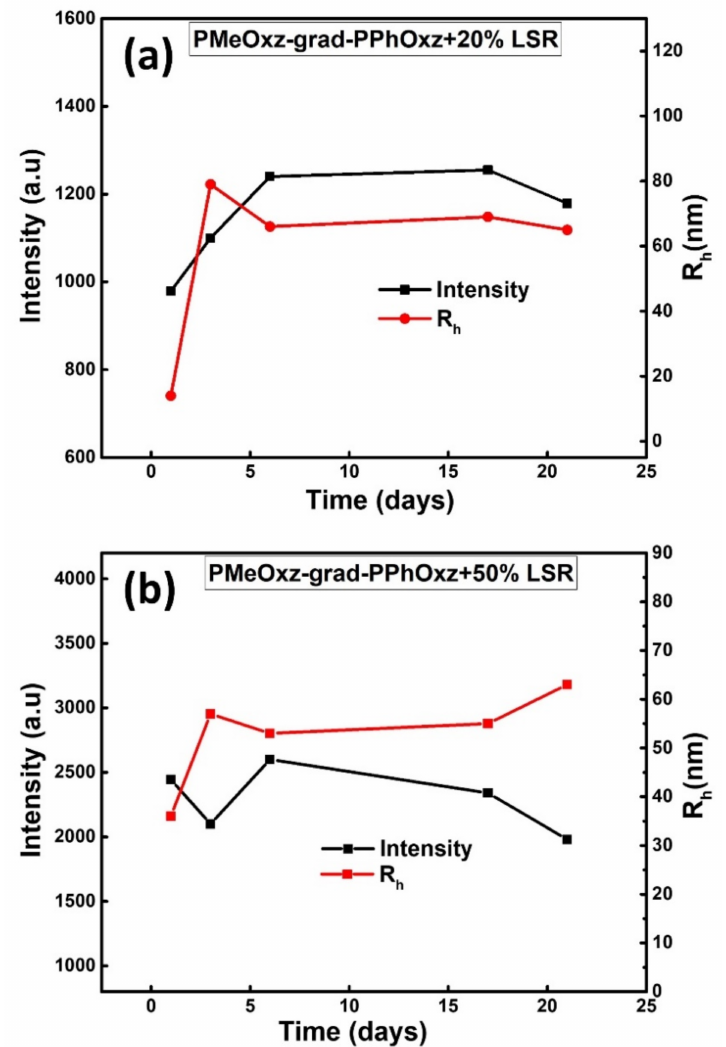
Figure 6. Scattered intensity and R h measurements (from cumulant analysis) versus time obtained from DLS of ( a ) PMeOxz 72 -grad-PPhOxz 28 + 20% LSR and ( b ) PMeOxz 72 -grad-PPhOxz 28 + 50% LSR nanocarriers in aqueous